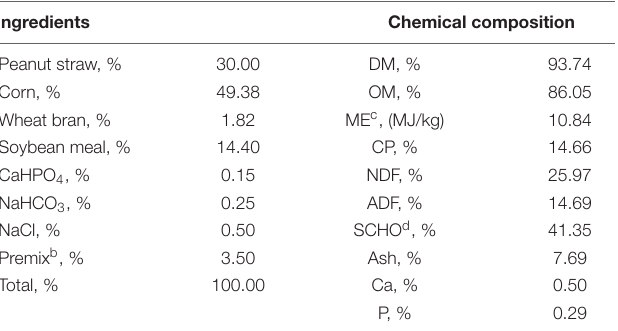
TABLE 1 | Composition and nutrient levels of experiment basal diets (air-dry basis, %) a